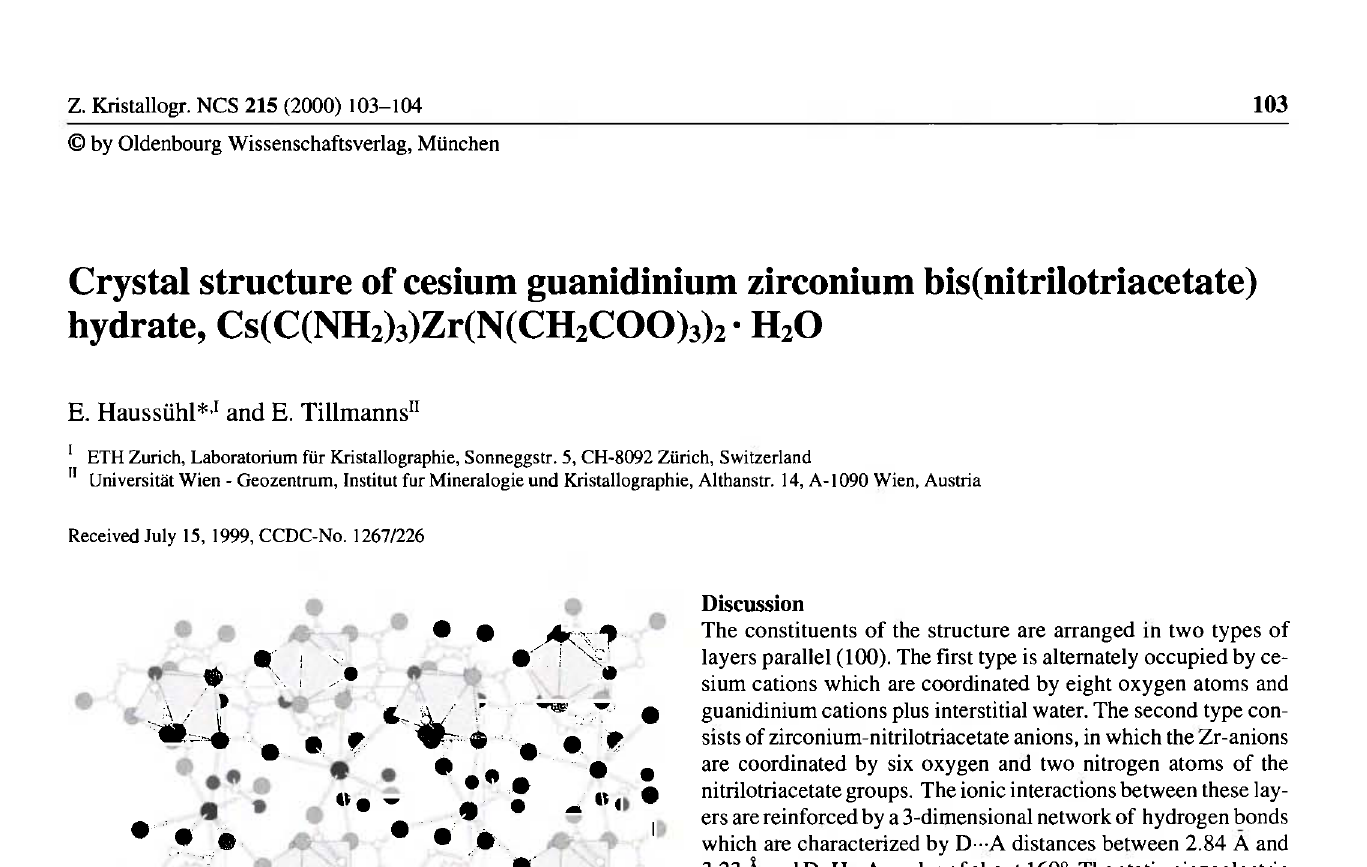
Table 1. Data collection and handling.